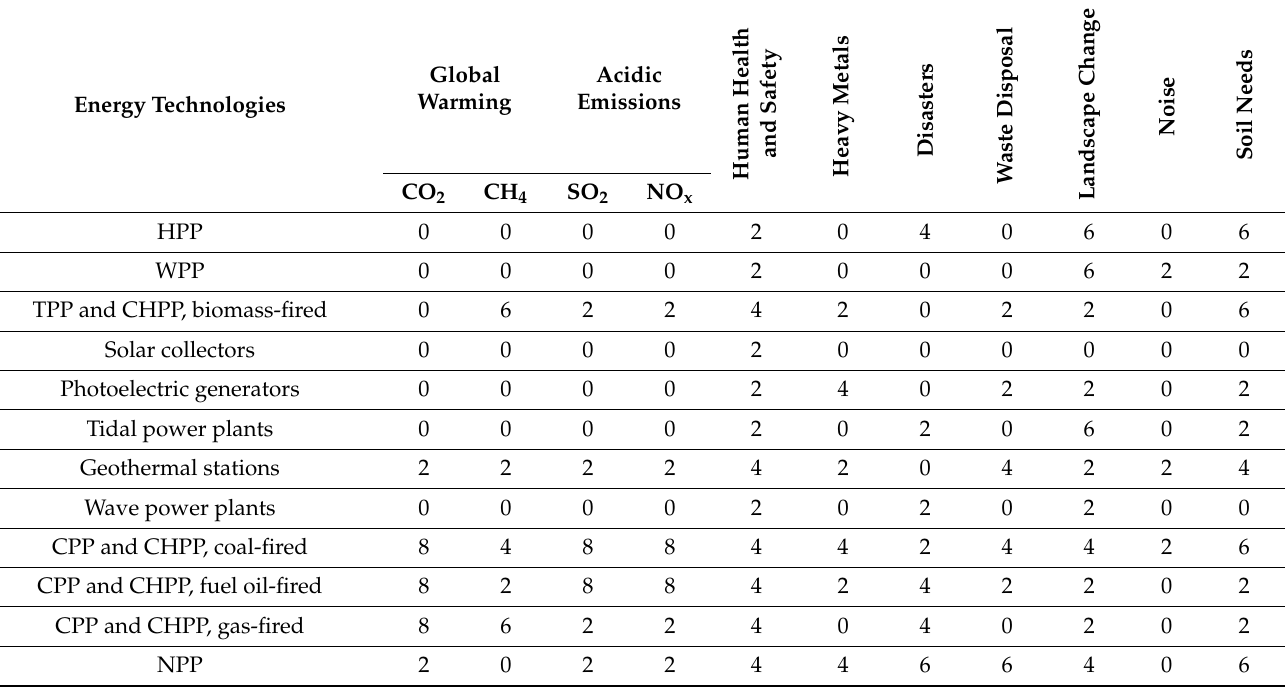
Table 2. Qualitative environmental impact assessment of various energy technologies (in scores).